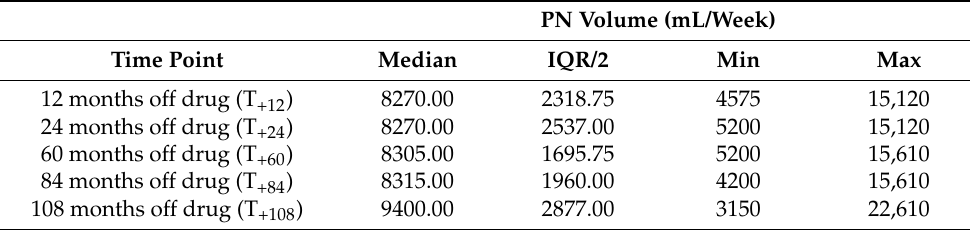
Table 3. Weekly parenteral nutrition (PN) volume in the study sample after stopping teduglutide.